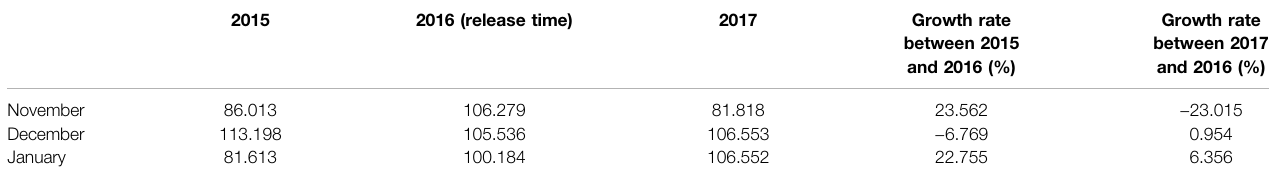
TABLE 2 | AQI comparison for the same period of the month (2015 – 2017).